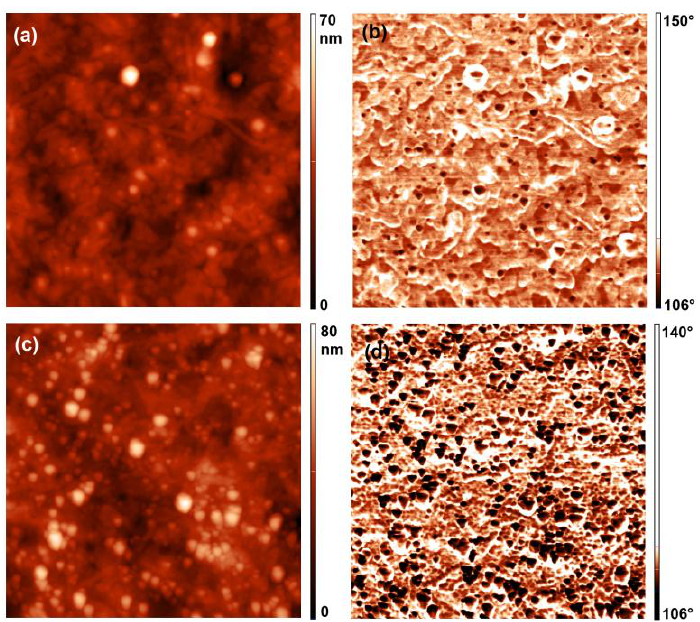
Figure 12. AFM topography (2 × 2 µm 2 ) and phase images of selected samples: ( a ) topography of the untreated sample; ( b ) phase image of the untreated sample; ( c ) topography of the sample treated with a fluence of 82 × 10 22 m –2 ; and ( d ) phase image of the sample treated with a fluence of 82 × 10 22 m –2 .